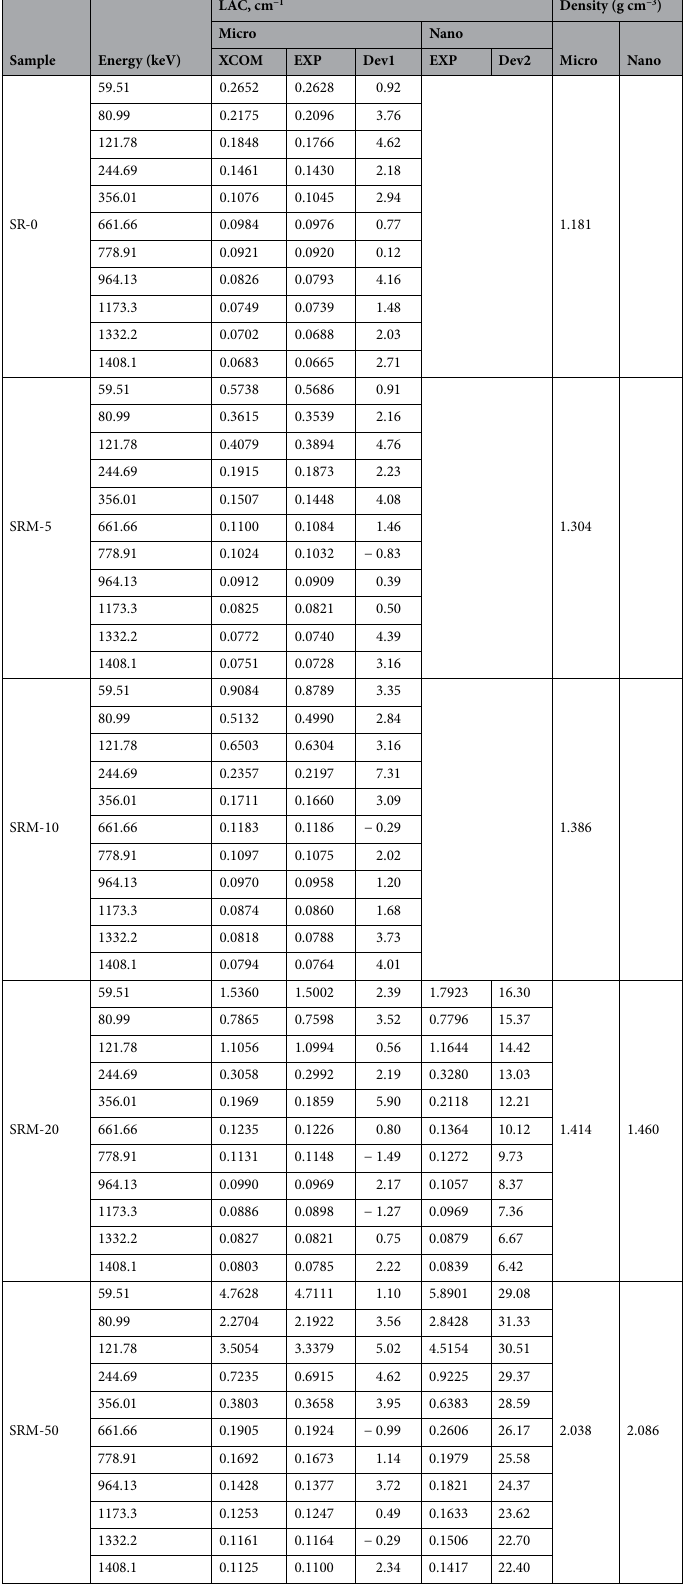
Table 2. Measured density, linear attenuation coefficients, relative deviation, and theoretical Xcom value for pure SR, micro SR/ PbO, and nano PbO/SR